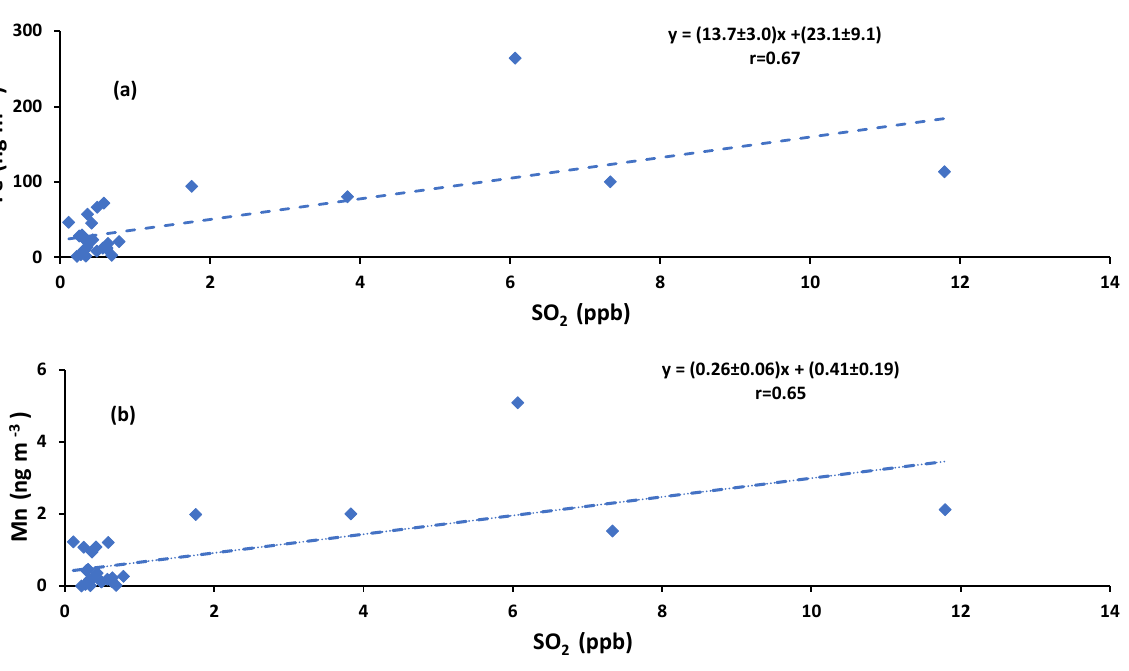
Figure A5. Concentrations of (a) Fe and (b) Mn measured in PM 2 . 5 versus the concentration of SO 2 .